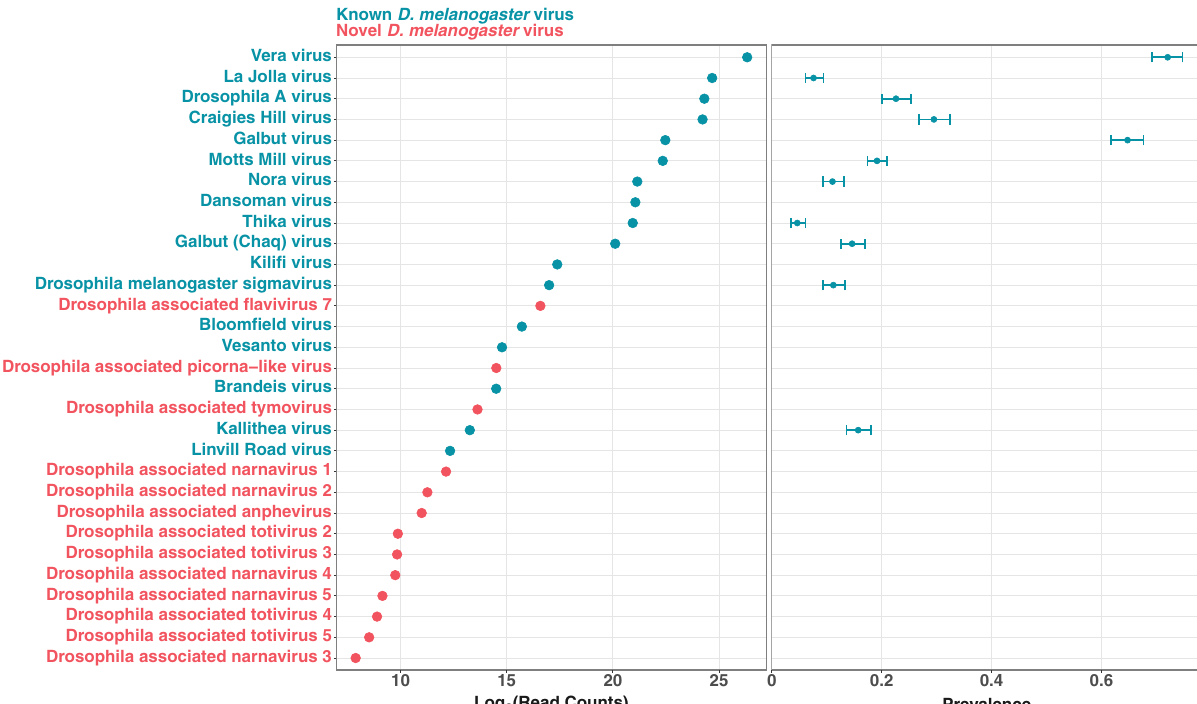
Fig. 1 Viruses associated with wild D . melanogaster . The total number of RNAseq reads that map to each virus (left). The prevalence of selected viruses estimated using quantitative PCR to test single fl ies for infection (right). Error bars are 95% con fi dence